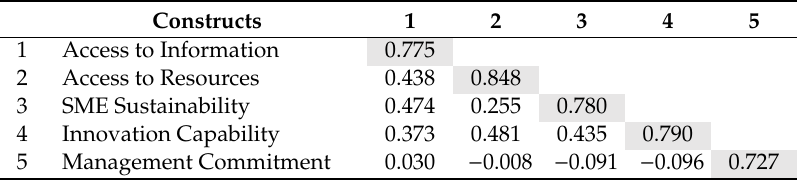
Table 2. Discriminant validity assessment using Fornell & Larcker criteria.